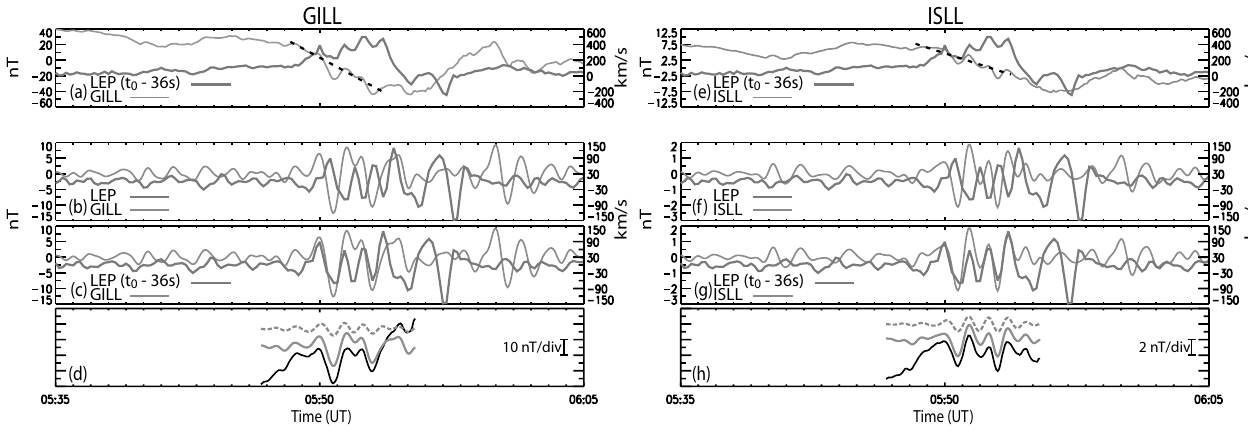
Fig. 5. (a) and (e) The GILL and ISLL, left and right respectively, raw magnetometer time-series. Overplotted in grey is the LEP v ⊥ x plasma flow shifted backward 36s to the time of maximum correlation between the BBF waveform and magnetometer Pi2 pulsations The dashed grey line is a linear fit to the raw magnetometer time-series used to remove the background magnetic field fluctuations, see panels (d) and (h) . (b) and (f) The Pi2 bandpass filtered (40–150s) magnetometer (black) and LEP v ⊥ x plasma flow (grey). (c) and (g) The same as (b) however the LEP v ⊥ x plasma flow has been shifted 36s backward to show the high correlation between the BBF waveform and ground-based Pi2 pulsations. Panels (d) and (h) are a comparison of two methods for separating the magnetometer Pi2 pulsations from the background magnetic field. The black trace is a subtraction of the raw magnetometer data from a linear fit to the data, cf. panel (a) . The two grey and dashed grey traces are the 40–150s and 55–90s bandpass filtered time-series. Note in panels (a) – (b) and (e) – (g) the left hand axis is the magnitude of the magnetic field and the right is the magnitude of the plasma flow. Table 2. Summarises the results at each magnetometer station for a maximum correlation lag with v ζx at Geotail. Magnetometer Maximum correlation Corresponding lag of BBF from t 0 (05:49:12UT) station squared Time